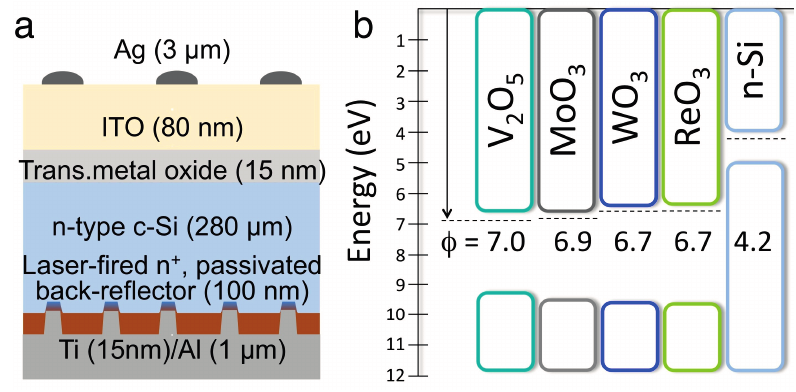
Figure 1. ( a ) Schematic of the transition metal oxide/n-Si heterojunction solar cell; ( b ) reported work functions for ReO 3 [13], V 2 O 5 , MoO 3 and WO 3 [14]. The valence and conduction band energy levels of c-Si are also